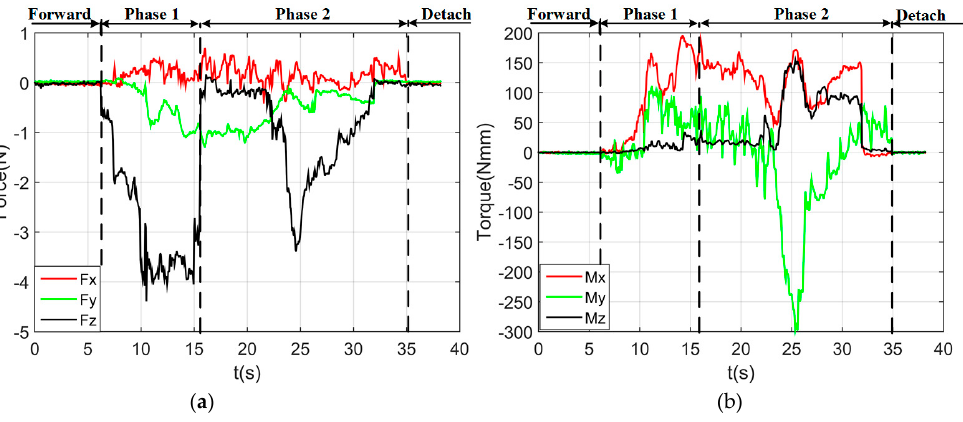
Figure 19. Square pieces: interacting forces and torques toward dual-arm operation (Phase 1: outside adjustment phase; Phase 2: inside adjustment phase). ( a ) Interaction forces; ( b ) interaction torques.